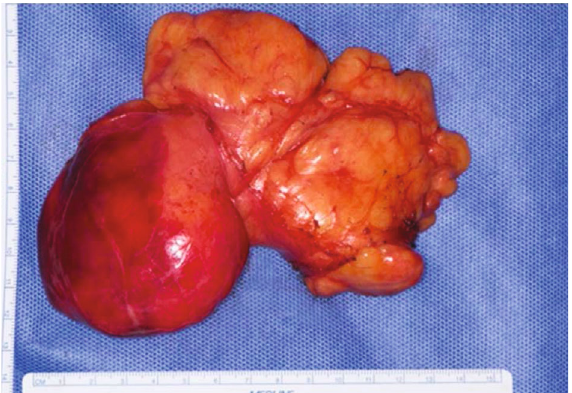
Figure 4: Image of the extracted mass.